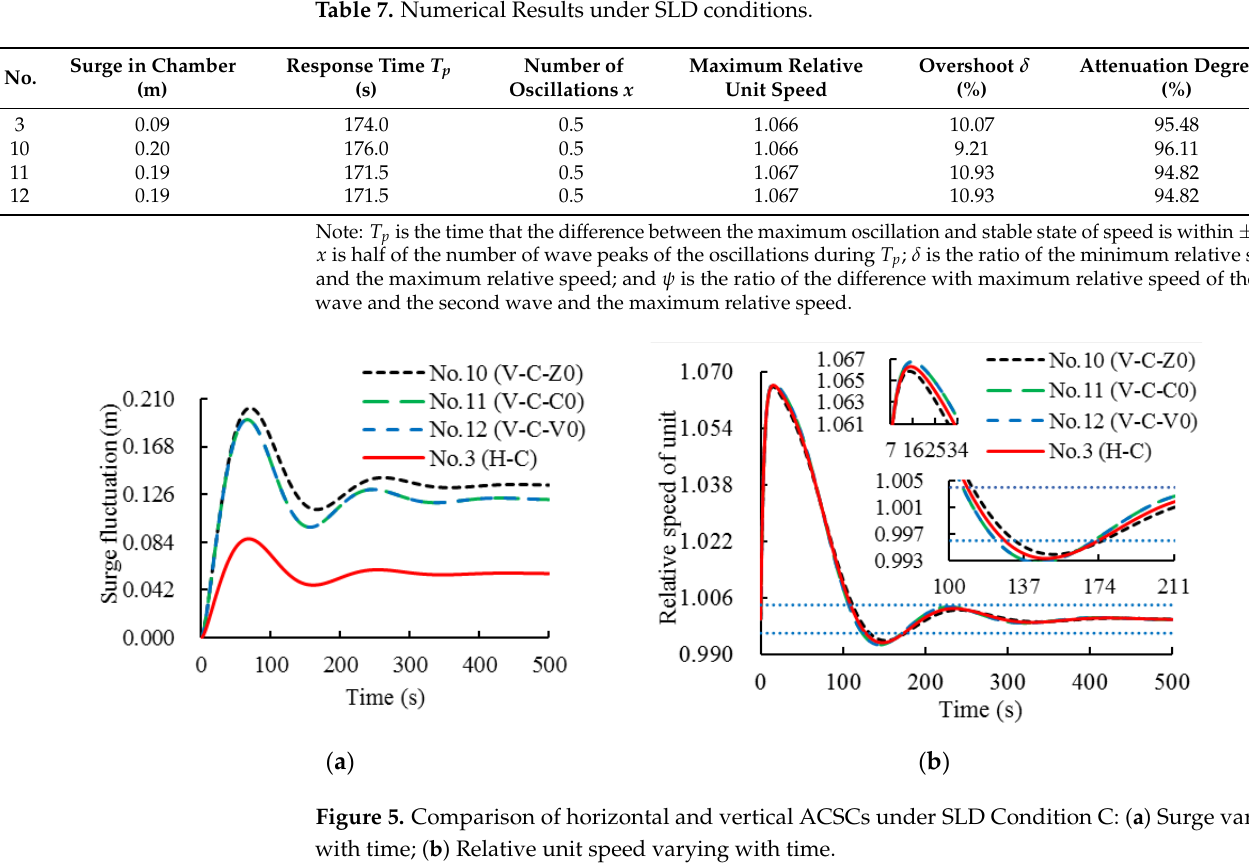
Table 7. Numerical Results under SLD conditions.